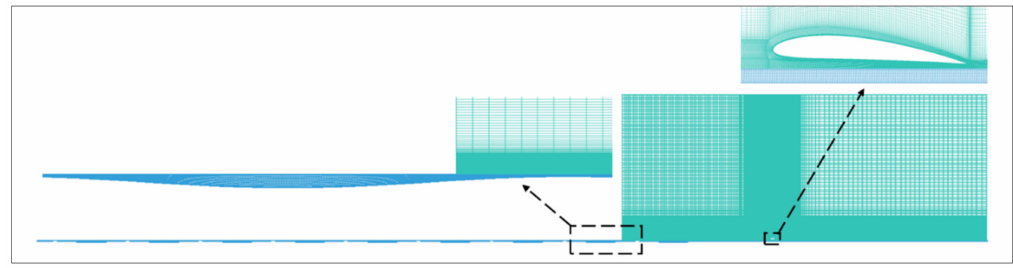
Figure 1. Computational domain for moving over wavy ground.